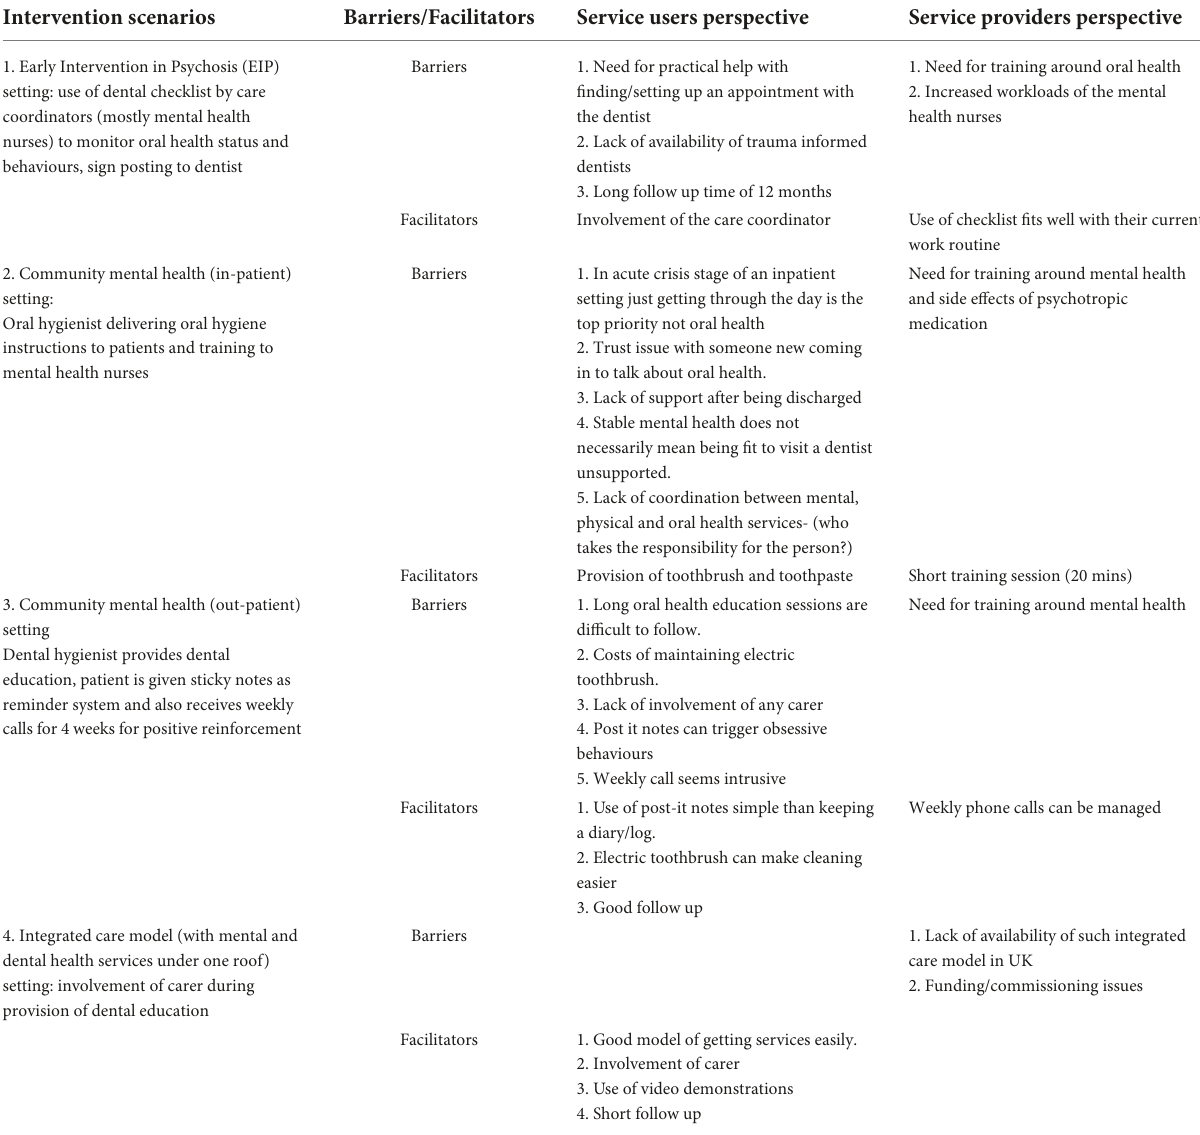
TABLE 3 Intervention Scenario specific barriers and